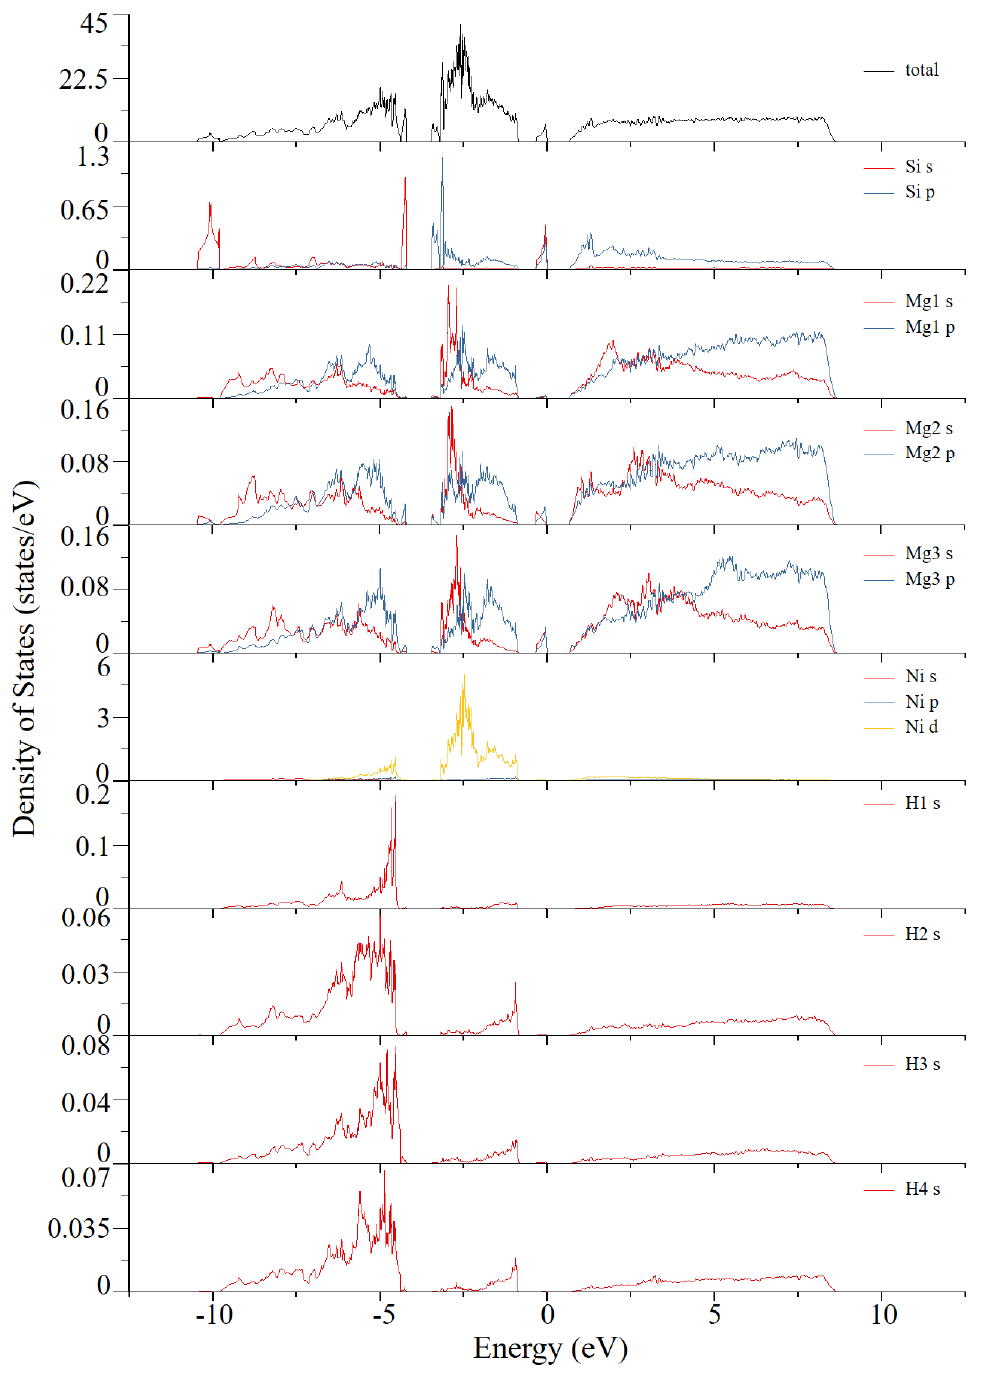
Figure 7. The calculated total and partial electronic density of states (DOS) for the Na-doped Mg2NiH4solid. The Fermi level is set at zero